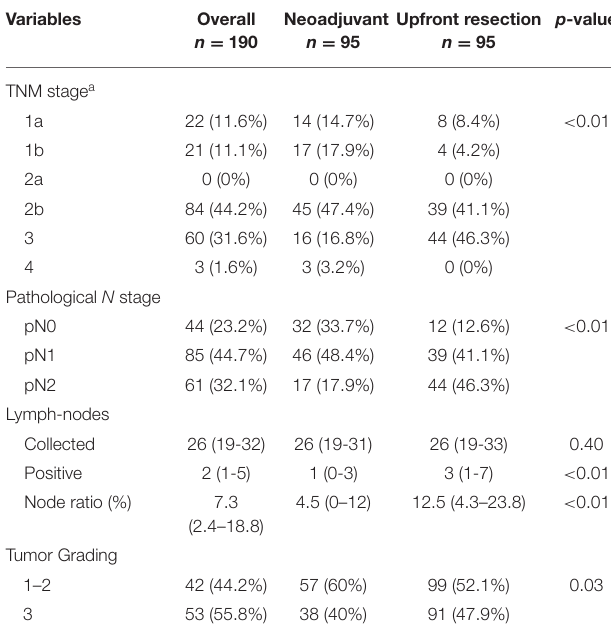
TABLE 5 | Postoperative outcomes. TABLE 6 | Pathological findings after propensity score